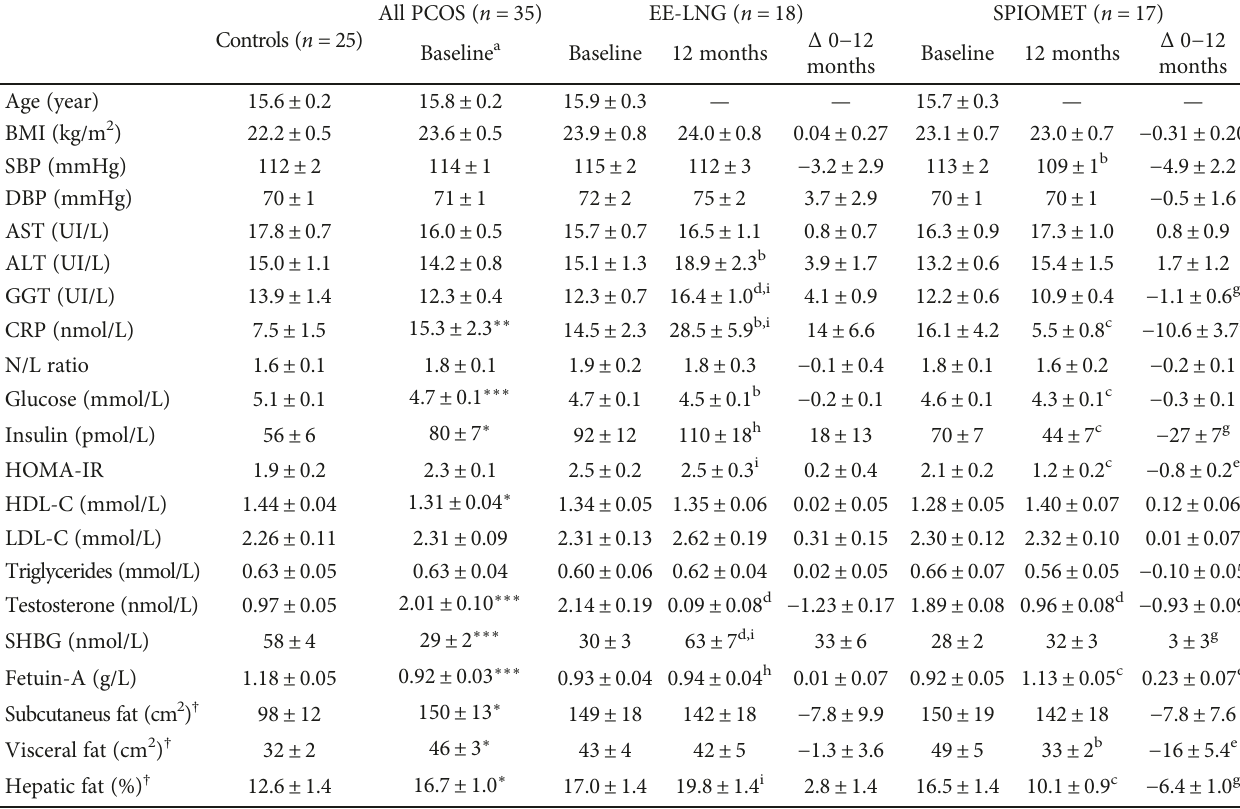
Table 1: Data from adolescent girls with polycystic ovary syndrome (PCOS) who were randomized to receive either ethinylestradiol- levonorgestrel (EE-LNG; n = 18 ) or low-dose spironolactone-pioglitazone-metformin (SPIOMET; n = 17 ) for 12 months.